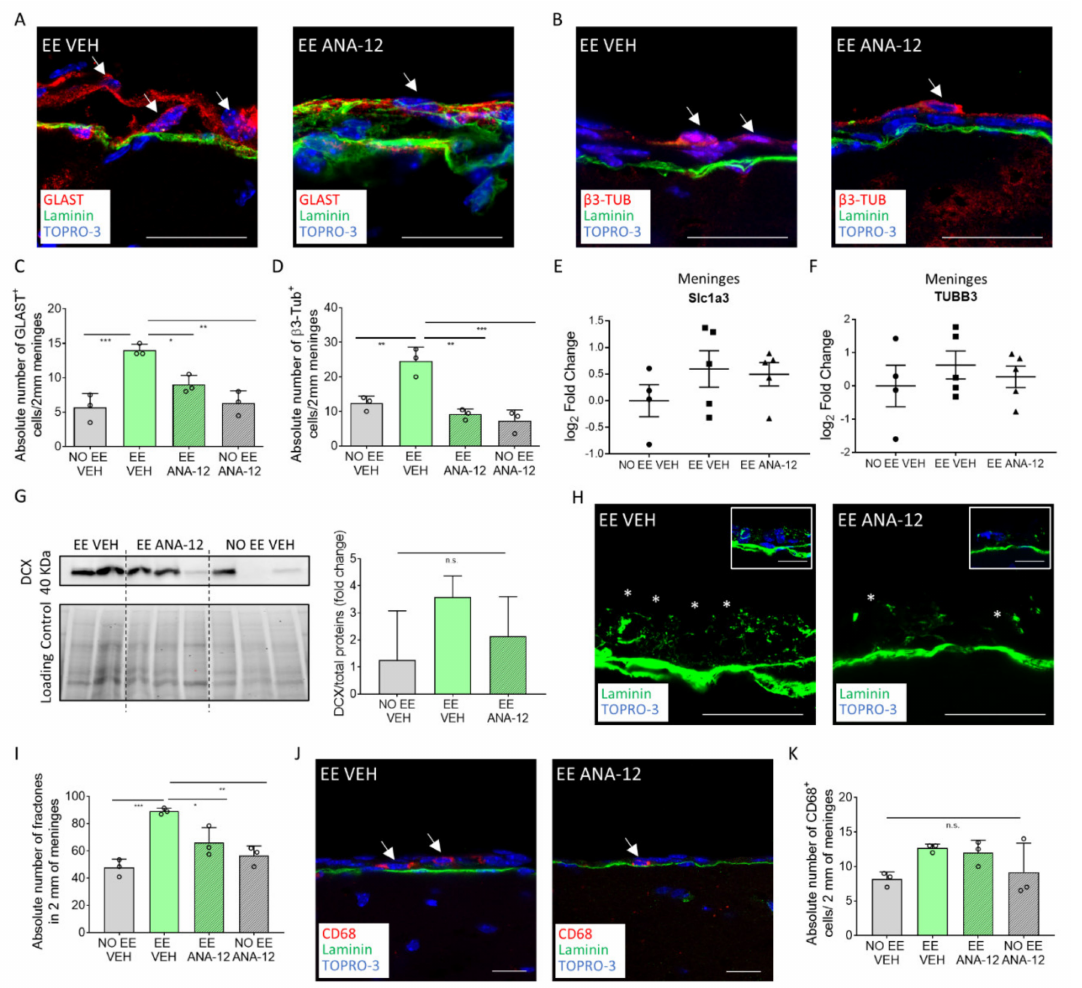
Figure 4. ANA-12 administration reverts EE-induced changes in the meningeal niche. ( A ) Sagittal brain sections of the CD1 mice, showing GLAST + (red) cells above the meningeal basal lamina (green) in the EE VEH and EE ANA-12 mice. ( B ) Sagittal brain sections of the CD1 mice, showing β 3-Tubulin + (red) cells above the meningeal basal lamina (green) in the EE VEH and EE ANA-12 mice. ( C ) Graph showing the number of GLAST + cells in 2 mm of the retrosplenial brain meninges of the NO EE VEH, EE VEH, EE ANA-12 and NO EE ANA-12 animals. ( D ) Graph showing the number of β 3-Tubulin + cells in 2 mm of the retrosplenial brain meninges of the NO EE VEH, EE VEH, EE ANA-12 and NO EE ANA-12 animals. ( E ) Graph depicting gene expression analysis for Slc1a3 (GLAST) in the NO EE VEH, EE VEH and EE ANA-12 mice. Expression levels are reported as the log 2 fold change with respect to the NO EE VEH mice. ( F ) Graph depicting gene expression analysis for TUBB3 ( β 3-Tubulin) in the NO EE VEH, EE VEH and EE ANA-12 mice. Expression levels are reported as the log 2 fold change with respect to the NO EE VEH mice. ( G ) Representative western blot analysis of mouse brain meningeal protein extracts, which shows the presence of the DCX protein in the EE VEH, EE ANA-12 and NO EE VEH samples (left panel). The graph shows the differential fold change in protein expression for the DCX protein in the NO EE VEH, EE VEH and EE ANA-12 mice with respect to the NO EE VEH mice (right panel). ( H ) Sagittal brain sections of the CD1 mice, showing fractones (*) identified via laminin (green) staining in the brain meninges of EE VEH and EE ANA-12 mice. An insert illustrates laminin staining (fractones) below the meningeal nuclei (TOPRO-3). ( I ) Graph showing the number of CD68 + cells in 2 mm of the retrosplenial brain meninges of the NO EE VEH, EE VEH, EE ANA-12 and NO EE ANA-12 animals. ( J ) Sagittal brain sections of the CD1 mice showing CD68 + (red) cells in the brain meninges of the EE VEH and EE ANA-12 mice. ( K ) Graph showing the number of fractones in 2 mm of the retrosplenial brain meninges of the NO EE VEH, EE VEH, EE ANA-12 and NO EE ANA-12 animals. Data are presented as the mean ± SEM, and n.s. = not statistically significant. * p value ≤ 0.05. ** p value ≤ 0.01. *** p value ≤ 0.001. In ( A , B , H , J ), the nuclei are in blue (TOPRO-3 nuclear staining). ( J ) is a single-plane confocal images. ( A , B , H ) are the maximum intensity projections of the z-stack confocal images. The scale bars represent 20 µ m. White arrows indicate positive cells, while asterisks indicate